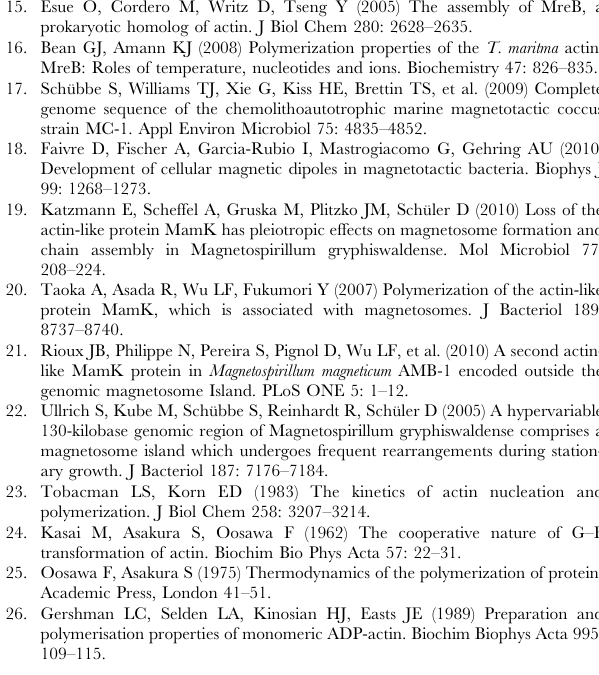
pre-stained protein ladder, Fermentas). The gels were stained with brilliant coomassie blue G-250. (TIF) Figure S2 Thermal stability of MamK and determina- tion of the a -helical content. Thermal denaturation of MamK (1 mg/ml) was measured by circular dichroism at 222 nm in polymerisation buffer as a function of temperature. The melting temperature of MamK was 66 u C. The insert shows the change in the helical content of MamK as a function of temperature. The fractional helicity (f H ) was calculated using the equation [( h 222 – 3000)/( 2 36000 2 3000)] where h 222 is the mean molar residual ellipcity at 222 nm and was determined as 44%. (TIF) Equation S1 Correlation function and translation diffu- sion coefficient expressions of scattered intensity.